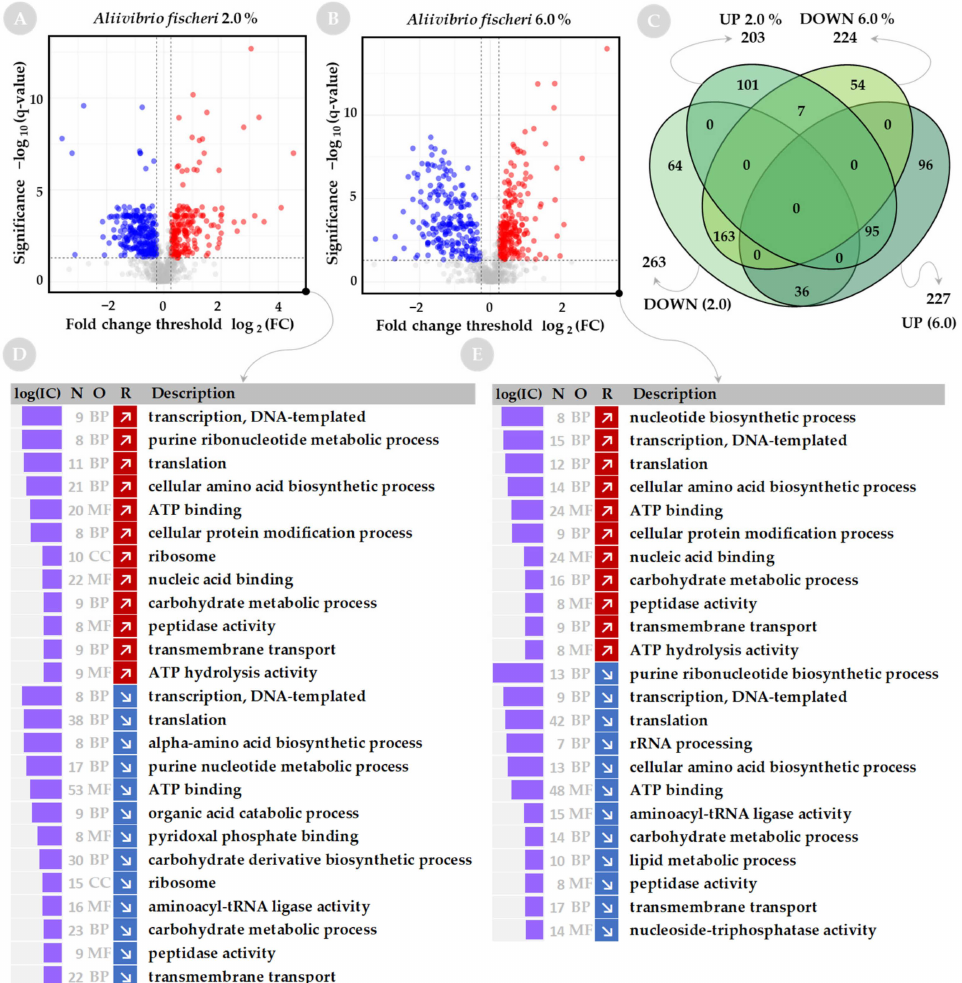
Figure 3. Global proteome changes in A. fischeri in response to low (2.0%) and high (6.0%) salinity stress. Volcano plots presenting significantly up- and down-regulated proteins upon ( A ) low and ( B ) high salinity. Protein abundance, presented as log 2 -transformed fold change (FC) calculated versus protein abundance at optimal salinity, is plotted against the statistical significance presented as − log 10 -transformed q -value. Vertical and horizontal dashed lines indicate fold change thresholds set at |log 2 (FC)| ≥ 0.25 and − log 10 ( q -value) of < 1.3, respectively. Proteins with significantly increased and decreased levels are shown as red and blue dots, respectively. ( C ) Venn diagram showing numbers of significantly up- and down-regulated proteins at respective salinities; the total number of proteins with changed abundance is indicated outside each set. Annotation analysis of proteins with changed abundance upon ( D ) low and ( E ) high salinity. Schemes include the following columns: log-transformed information content (IC) sore; the number of genes covered within the category